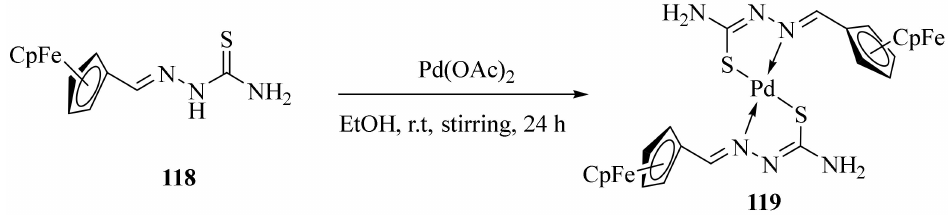
have been obtained by combining the ligands 120a – e with [PdCl 2 (PPh 3 ) 2 ] in a 1:1 molar ratio (Scheme 58) [36]. The reaction mixture was stirred for 4 h at room temperature to give the complexes 79–81% yields (Scheme 58) [36]. X-ray structure analysis of the obtained com- plexes showed that the coordination geometry around palladium(II) could be described as distorted square planar; the palladium ion was bonded to the monobasic bidentate NS - donor ligand in such a way that a five-membered ring was formed, and the remaining sites were occupied by one chlorine and one triphenylphosphine [36]. The anti-cancer activ- ity of the complexes was compared with that of the well-known anti-cancer drug cisplatin, and it was inferred that complex 121d exhibited comparable activity. All the complexes displayed moderate anti-cancer activity against A549 and MCF7 cancer cell lines and less toxicity towards the normal cell line. The morphological changes assessed by staining methods and DNA fragmentation revealed that cell death occurred by apoptosis